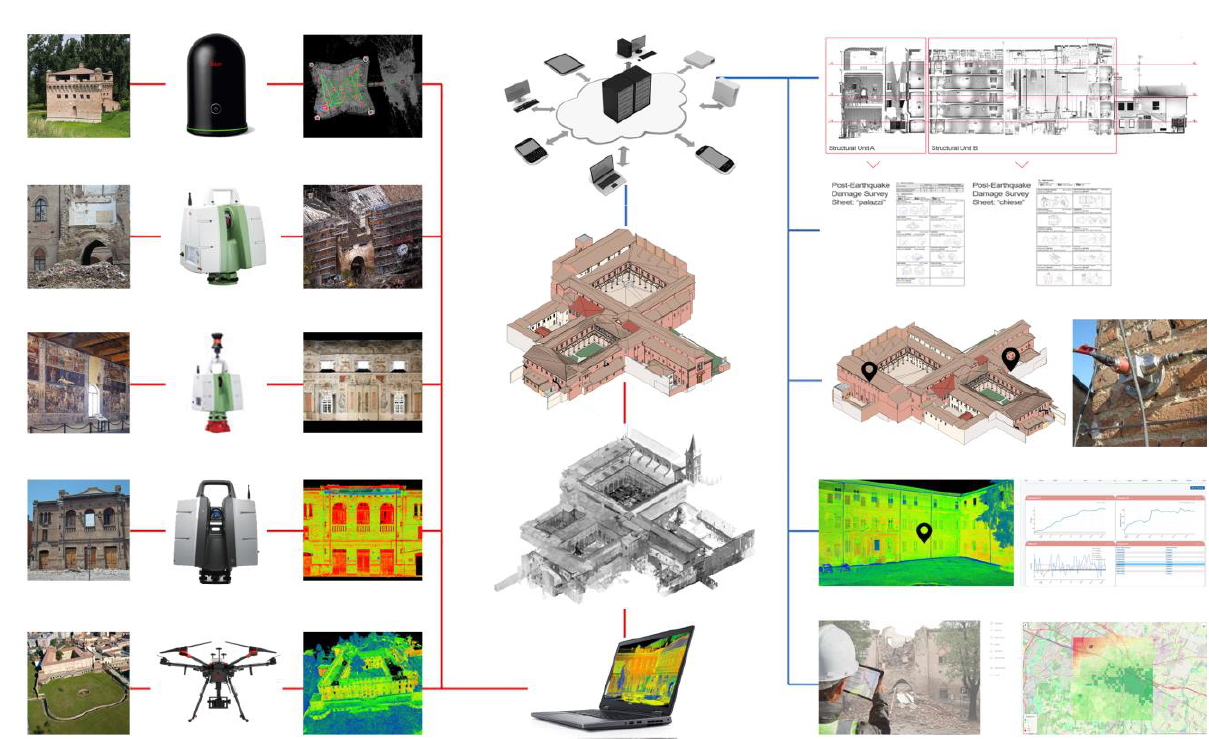
Figure 1. Integrated 3D seismic damage survey